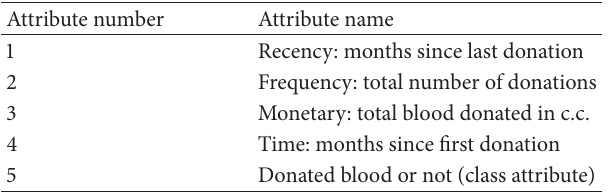
Table 3: Blood transfusion service center data set attribute informa- tion.